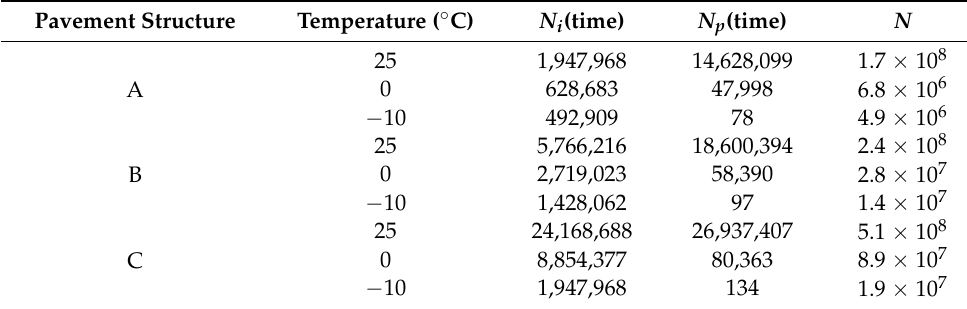
Table 12. Entire fatigue crack life of semirigid base asphalt pavement surface. Pavement